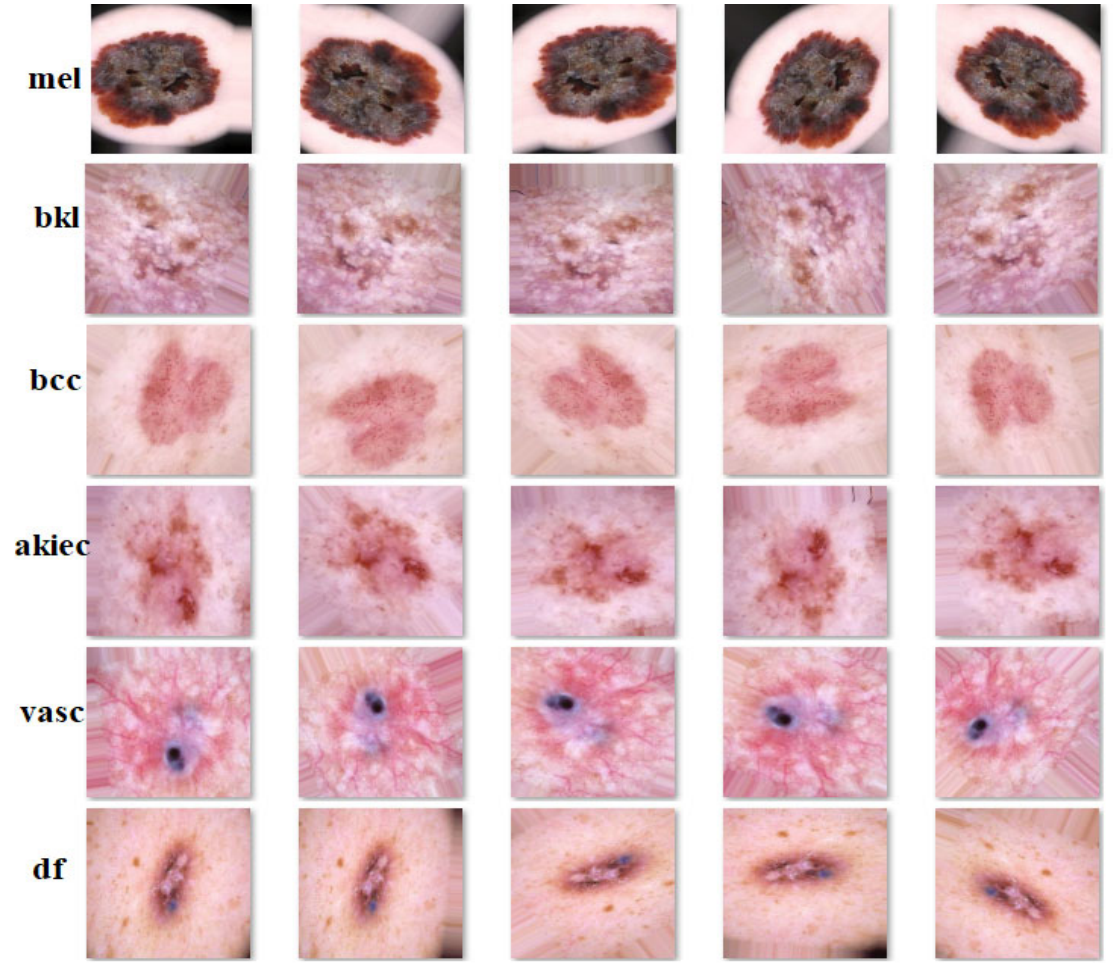
Figure 8. Sample dermoscopic images of skin lesions after data augmentation.